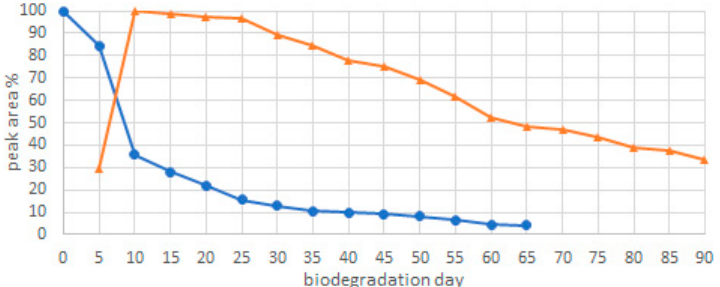
Figure 6. The breakdown plot of chromatographic peak areas (UV chromatogram at 280 nm) against days of biodegradation test obtained for Lusowo lake, spring ( BPA, p -HAP).